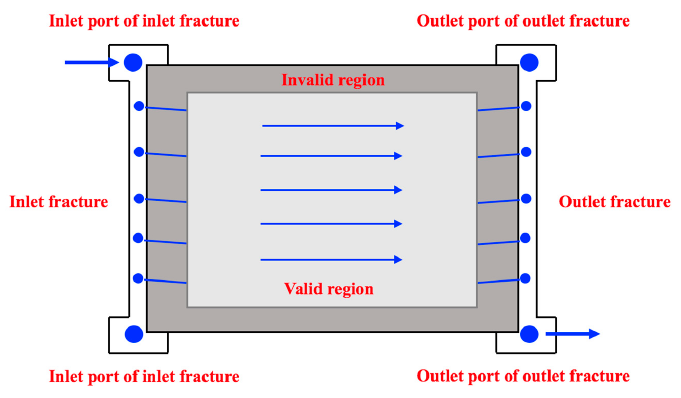
Figure 3. Schematic of the mask frame and typical flow direction.